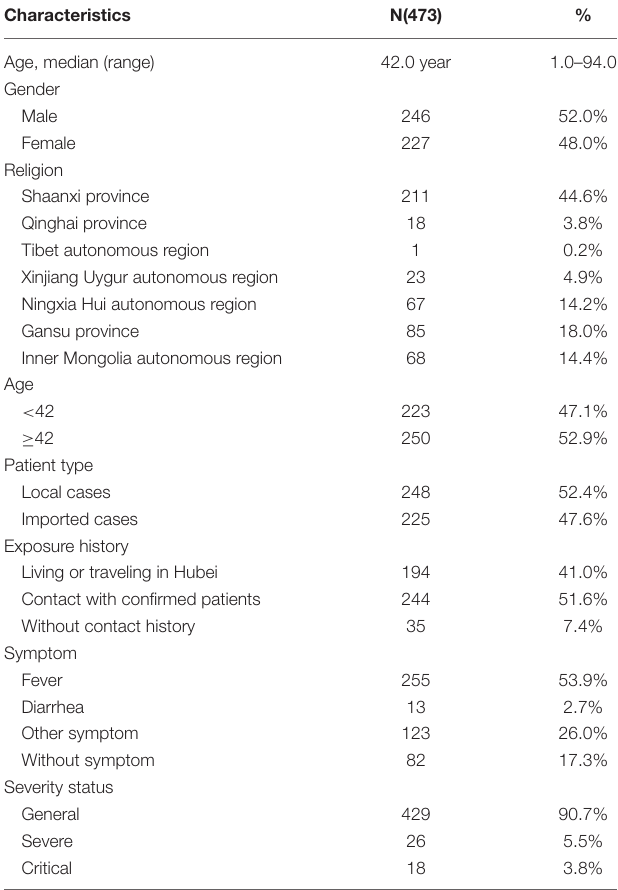
TABLE 2 | Clinical characteristics of COVID-19